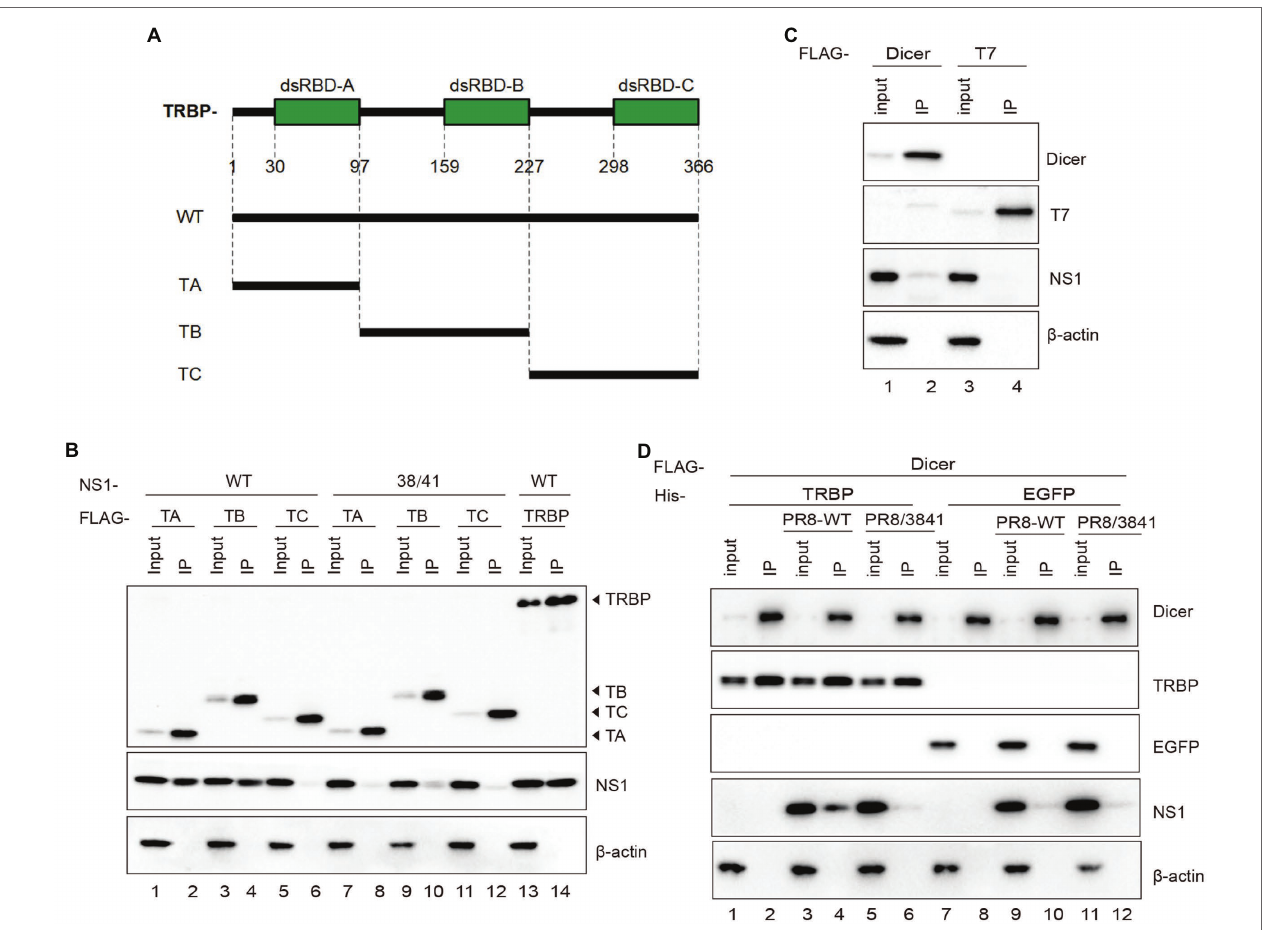
FIGURE 4 | The dsRBD-A and dsRBD-B of TRBP are critical for interacting with NS1. (A) Domain architecture of TRBP protein (TRBP-WT) and the generated mutant constructs (TA, TB, and TC). (B) Immunoprecipitation of PR8 NS1 protein with different mutants of TRBP proteins. PR8 NS1 and the indicated FLAG-tagged constructs were co-transfected into 293 T cells, followed by FLAG immunoprecipitation. FLAG-tagged proteins, NS1, and β -actin were detected with specific antibodies. (C) The weak interaction between Dicer and NS1. 293 T cells were transfected with FLAG-Dicer or FLAG-T7 for 24 h before infected with PR8-WT (MOI = 1) for 24 h and processed as in (B) . (D) NS1 participates in the complex with TRBP and Dicer. 293 T cells were co- transfected with FLAG-Dicer and His-EGFP or His-TRBP for 24 h before infected with mock or PR8-WT (MOI = 1) or PR8/3841 (MOI = 1) and then processed as in (B)